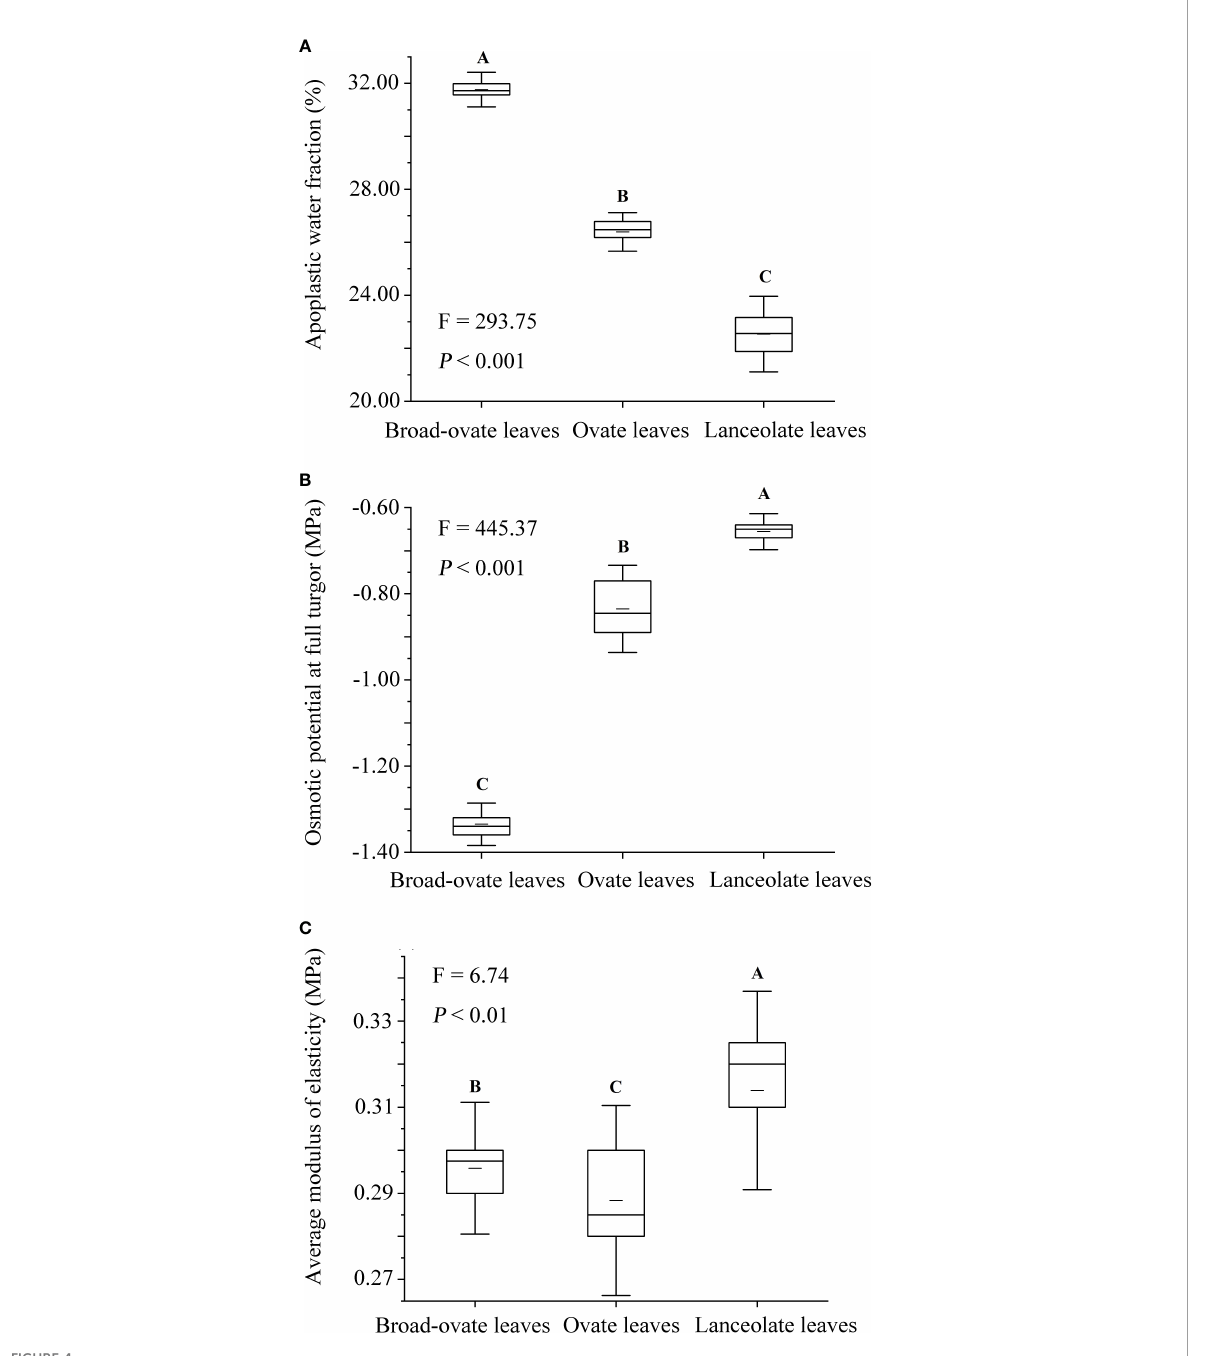
FIGURE 4 Differences in cellular water relations among the three types of heteromorphic leaves. The instructions of P , F , and other capital letters are shown in Figure